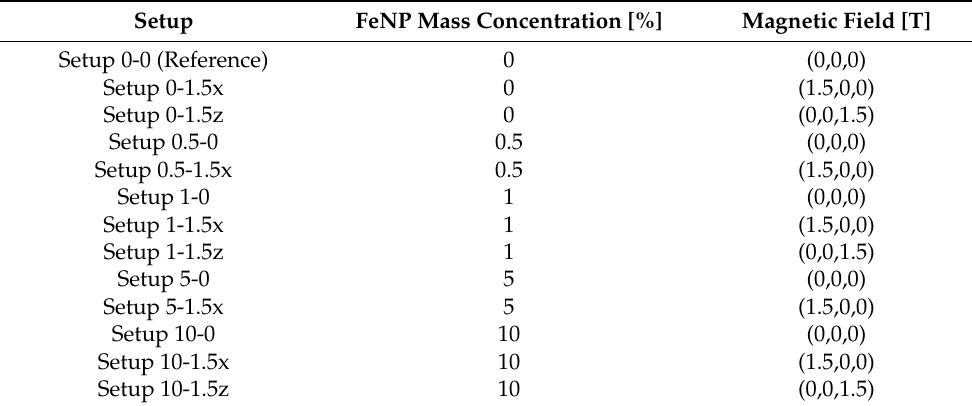
Table 1. List of studied configurations for the X-ray beam flowing along the negative (decreasing) z -axis direction.